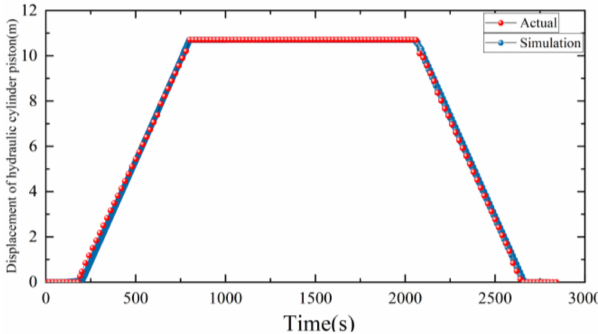
Figure 11. Piston lifting displacement.